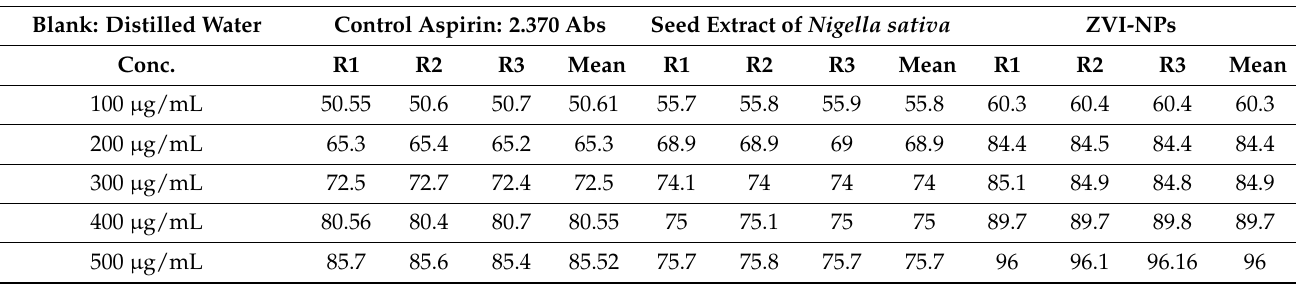
Table 4. Statistical analysis of % inhibition in protein denaturation showing statistically significant ( p < 0.01)